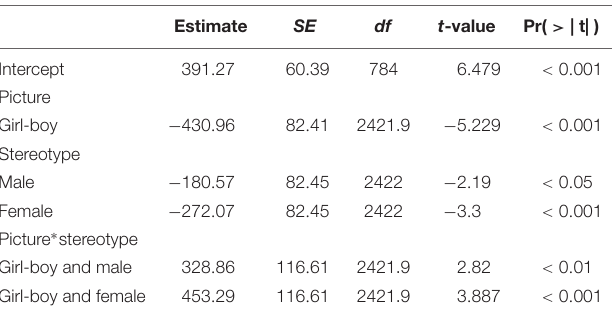
TABLE 2 | Model estimates for our best fitting model, including Picture and Stereotype as fixed factors (main and interaction effects) and participants and items as random